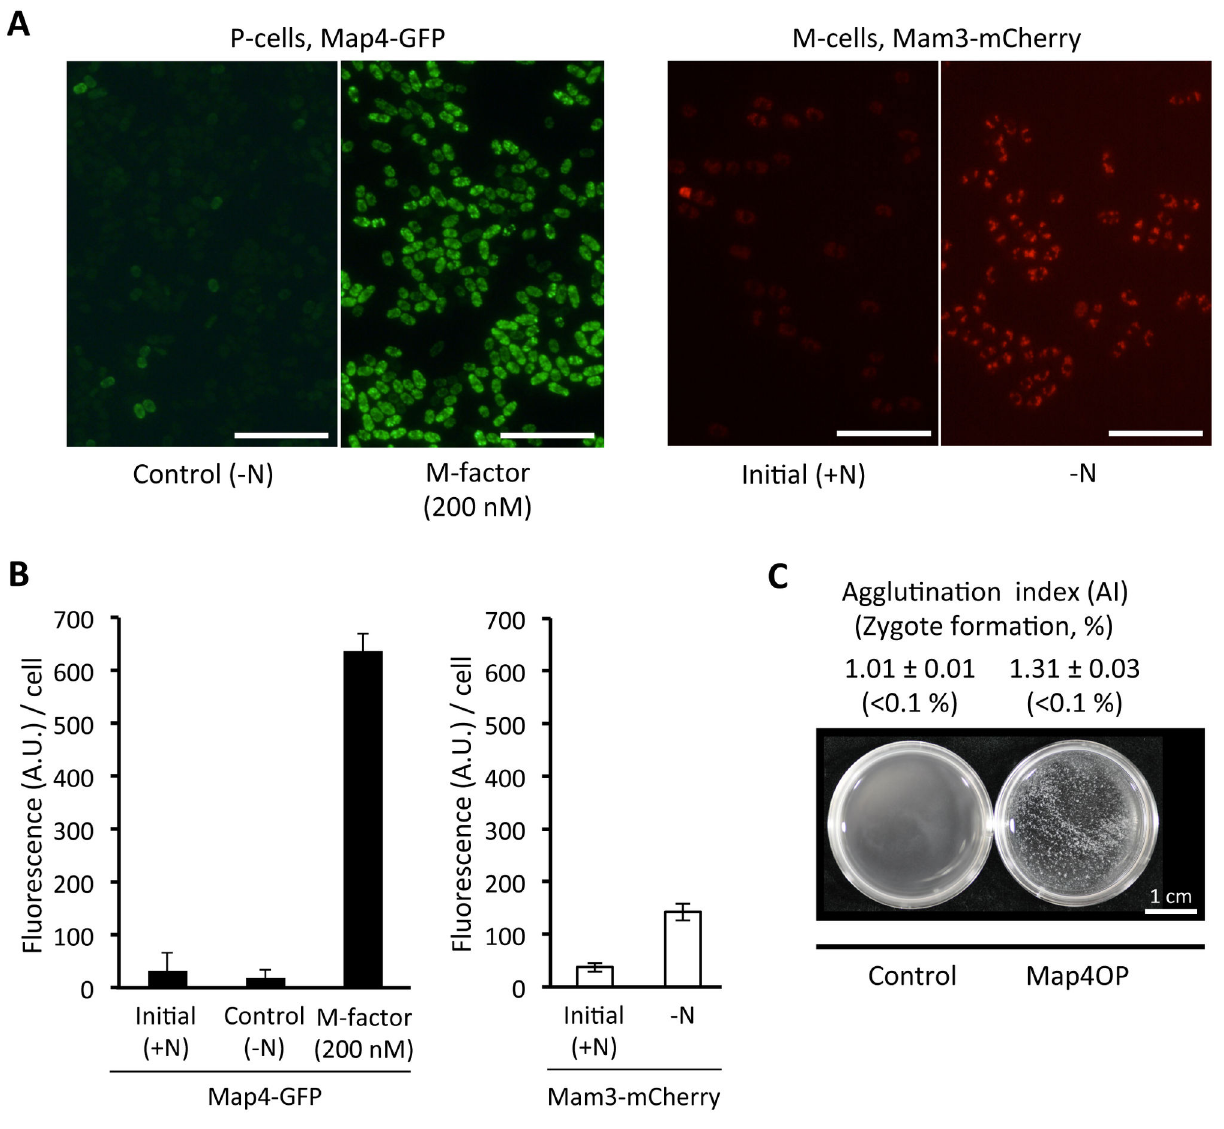
Figure 3. Expression of mating-type-specific adhesin proteins, Map4 and Mam3 (A, left). A heterothallic h + strain (FS103) carrying a map4 - GFP fusion gene integrated at the authentic chromosomal locus was precultured in SSL+N for 18 hr, then shifted to SSL−N with or without 200 nM of M-factor, and cultured for 4 hr. (A, right) A heterothallic h − mam2Δ strain (SS1463) carrying a mam3-mCherry fusion gene integrated at the original chromosomal locus was incubated for 4 hr in SSL−N (−N). Scale bar, 50 µm. (B) Quantification of Map4-GFP and Mam3-mCherry fluorescence. The intensity was quantified by image analysis using Image-J software. At least 8 different areas were analyzed. Means of arbitrary units (A.U.) with standard deviations are presented. (C) Induced agglutination by overexpression of Map4. Strain SS1290 ectopically overexpressing map4 + driven by the nmt1 promoter was precultured in MM+N without thiamine for 12 hr and then cultured in MM−N for 4 hr (Map4OP). The same strain was transformed by the pSLF173 empty vector [43] as a control. doi: 10.1371/journal.pone.0069491.g003 cause sexual agglutination (Figure S1C). These experiments indicate that Map4 is a major molecular target of M-factor action on sexual cell agglutination.